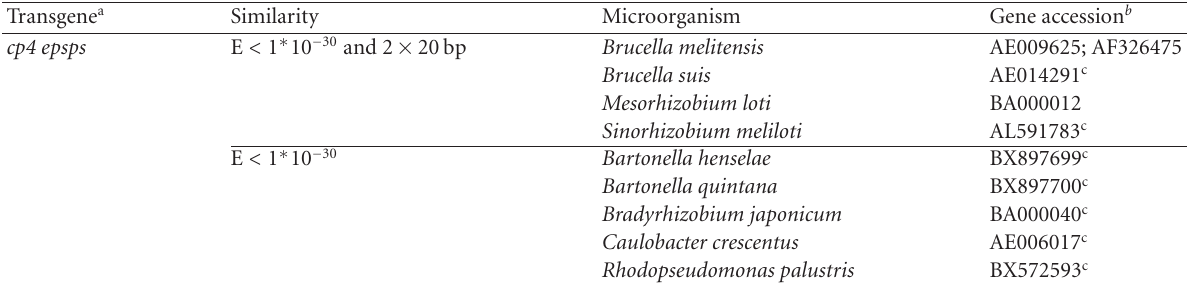
Table 3. Similarities of the codon-modified cp4 epsps transgene introduced into herbicide-resistant GM soybean to microbial genes. Transgene